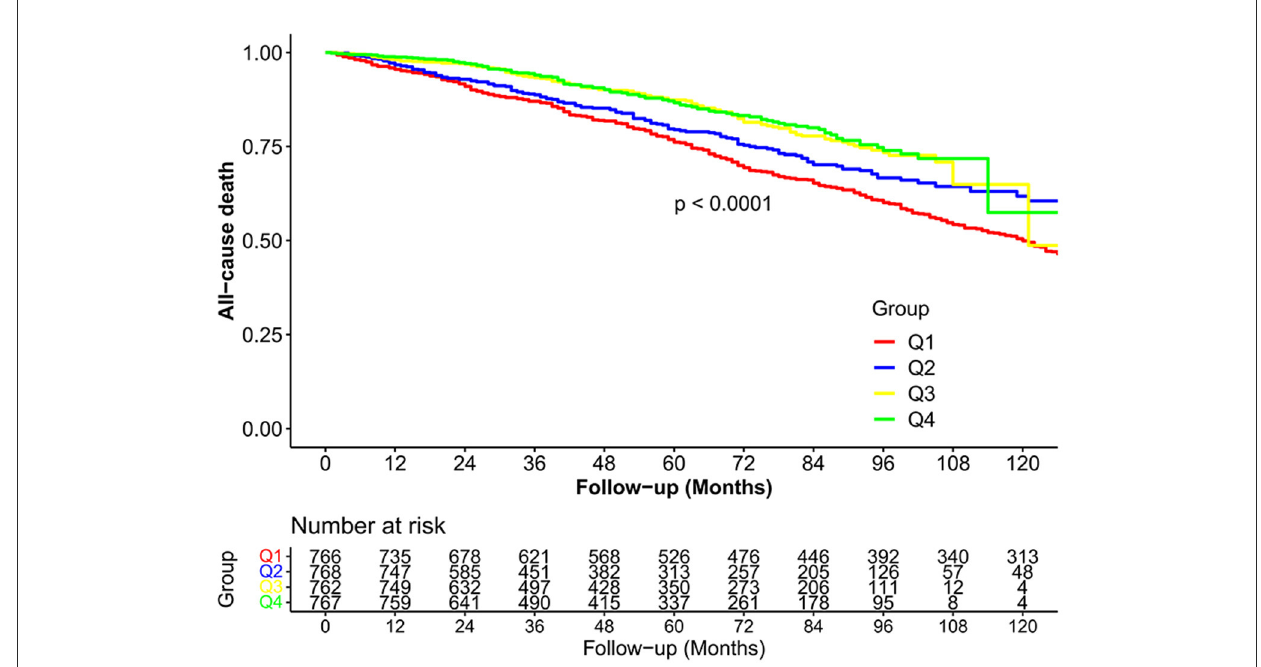
FIGURE2 The cumulative incidence of all-cause death in the four study groups during the follow-up period.